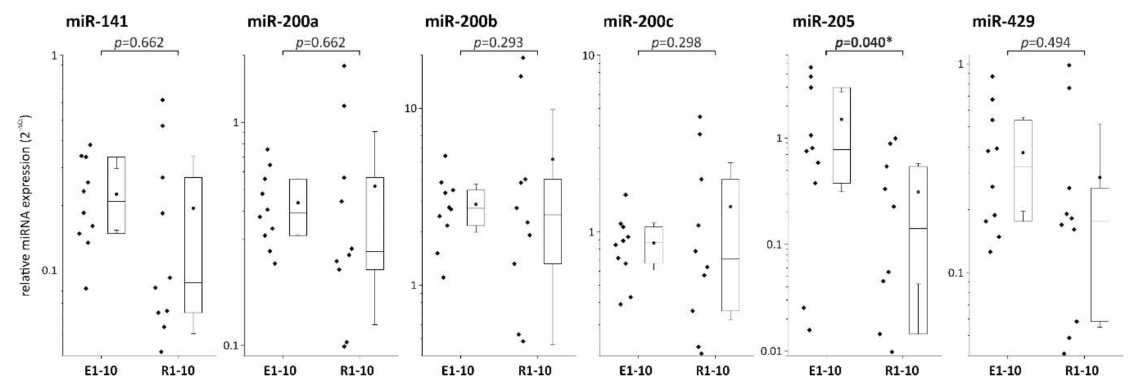
Figure 4. Expression analysis of microRNA (miR) family 200 and miR-205 in ESD-resected (E) and surgically resected (R) samples. * indicates significance ( p <